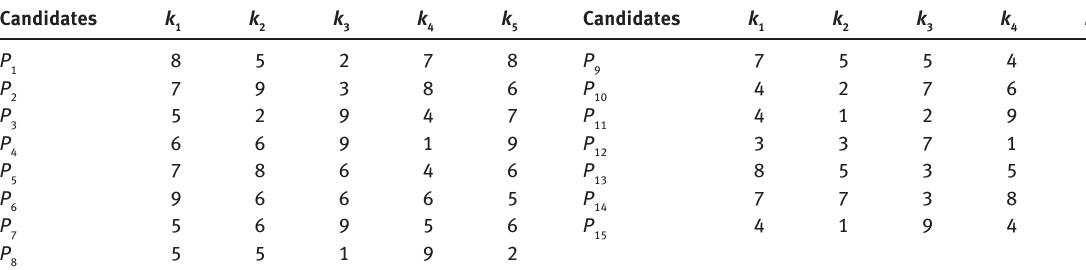
Table 3: Original Data on Criteria R